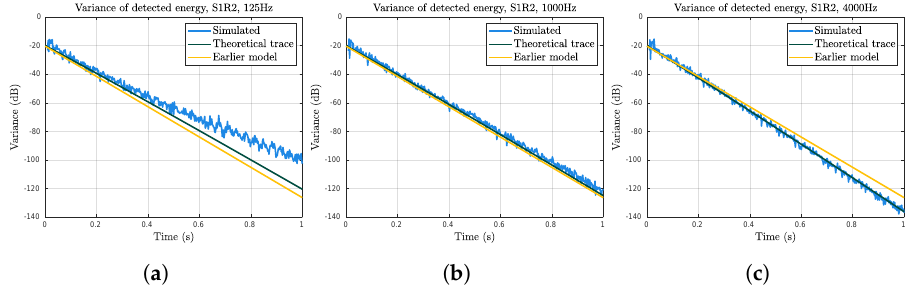
Figure 4. Comparison of the estimated variance of the detected energy in the impulse response, using the new expression Equation (7, green), the estimate found in [14] (yellow) and the results, based on 15 simulations (light blue). ( a ) shows the result for low scattering, ( b ) the results with more scattering and ( c ) the results when both scattering and air attenuation affects the